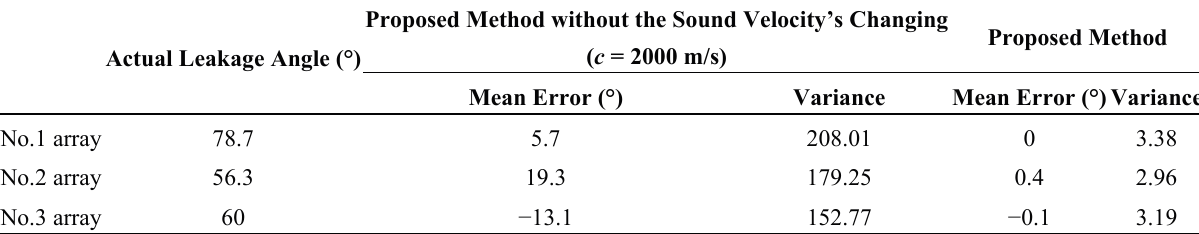
Table 4. The orientation results